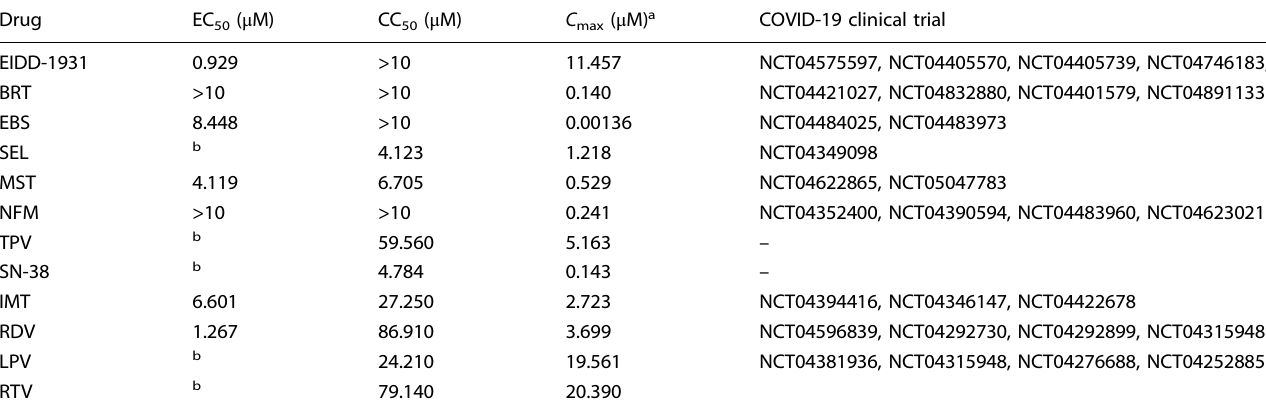
Table 1. Drug anti-SARS-CoV-2 ef fi cacy and cytotoxicity when administered in monotherapy as compared to C max obtained from the literature and regulatory documents.